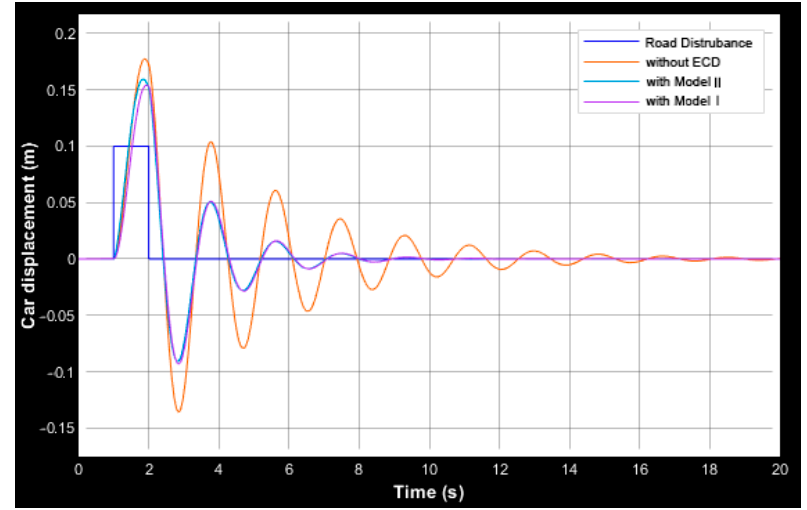
Figure 9. Comparison between the suspension displacement response during road disturbance, between Models I and II.